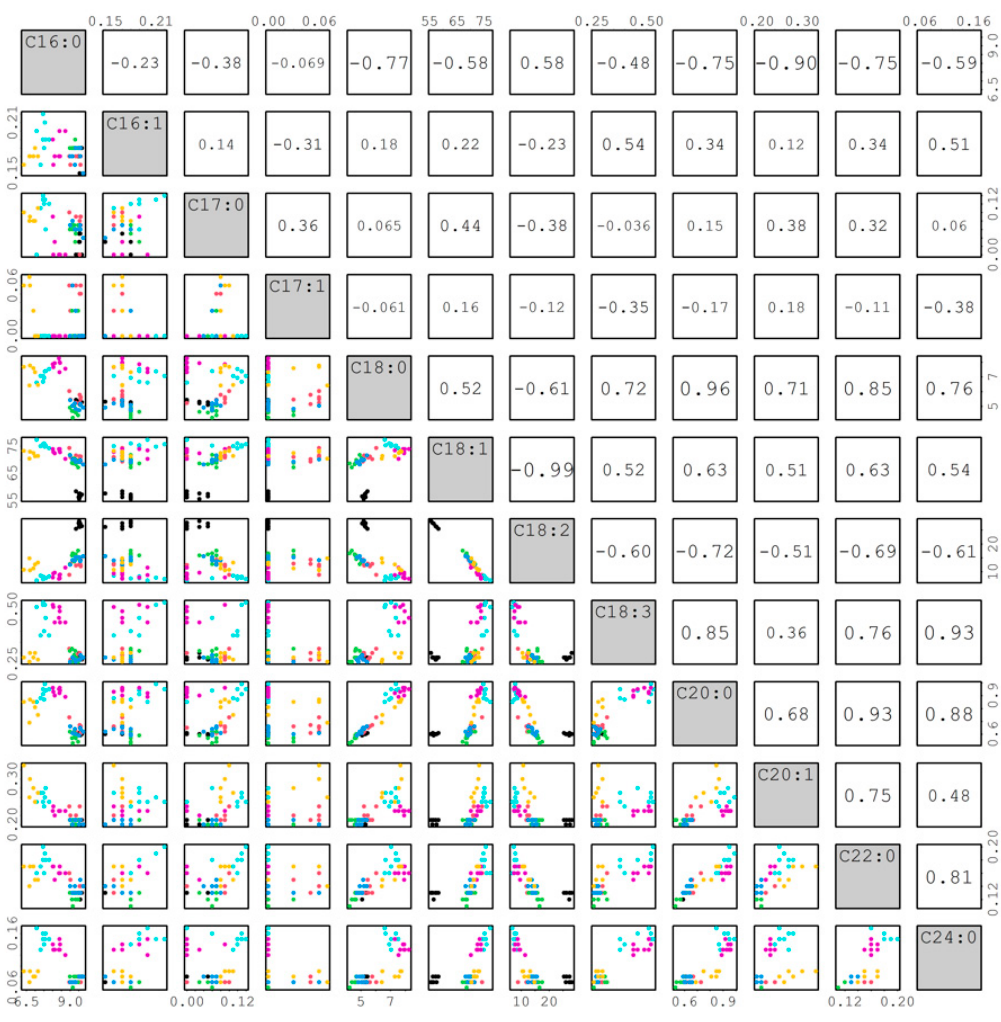
Figure 9. Correlations among di ff erent fa tt y acids in sesame.